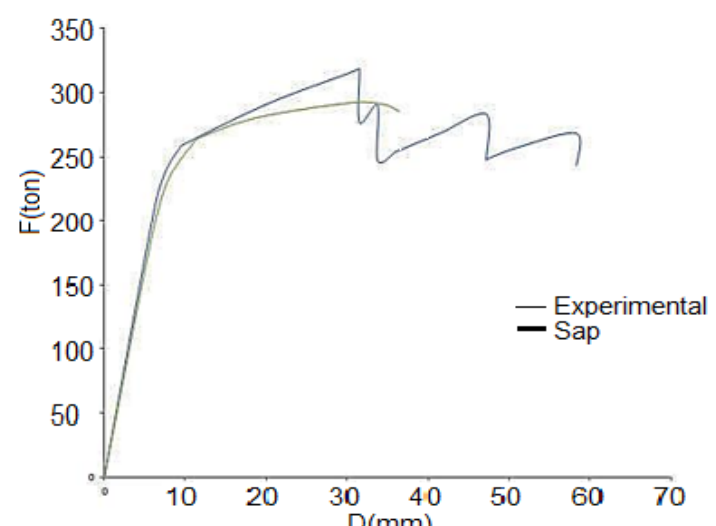
Fig. 5. Comparison of the force-displacement diagram of sample of Driver with Analyzed model in